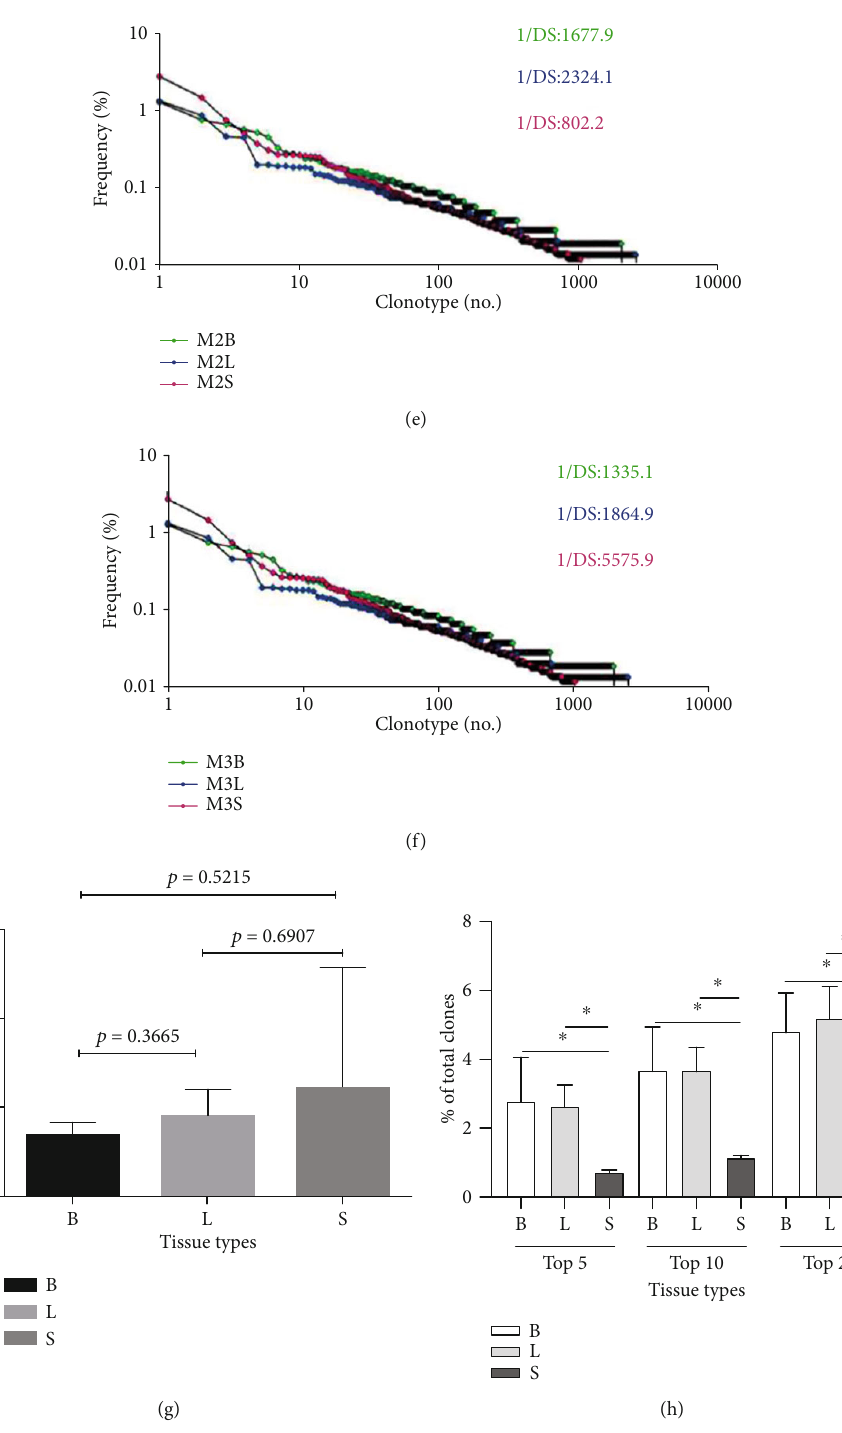
Figure 3: Clonotypes distribution plots (1/DS) (a – f) and statistical analysis of 1/DS (g) of CD4 + CD25 + T cell TCR β CDR3 repertoires among tissues from three 4T1 tumor-bearing BALB/c mice; statistical analysis (h) of the fi ve/ten/twenty most highly expanded clones of CDR3 repertoires in three 4T1 tumor-bearing BALB/c mice ( n = 3 , ∗ p ≤ 0 : 05